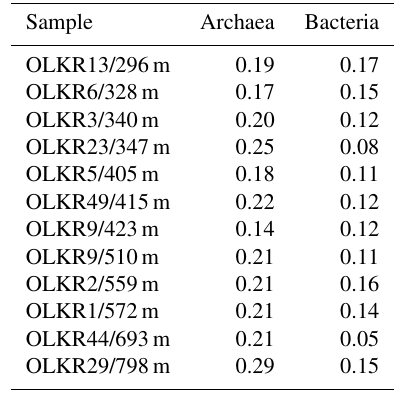
Table 3. The nearest sequenced taxon index (NSTI) values for the archaeal and bacterial communities in the 12 different samples ac- cording to PICRUSt. The NSTI value describes the sum of phyloge- netic distances of each OTU to its nearest relative with a sequenced reference genome, and measures substitutions per site in the 16S rRNA gene and the weighted frequency of each OTU in a sample data set. A higher NSTI value indicates greater distance to the clos- est sequenced relatives of the OTUs in each